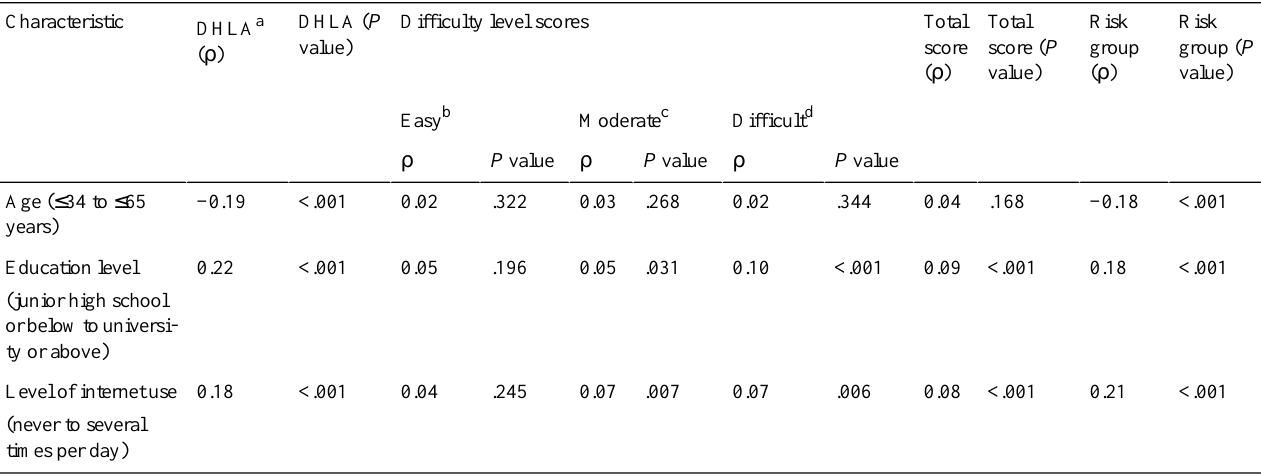
Table 2. Spearman correlation analysis of total scores for the DHLA and scores for accurate judgment across different difficulty levels and risk groups.